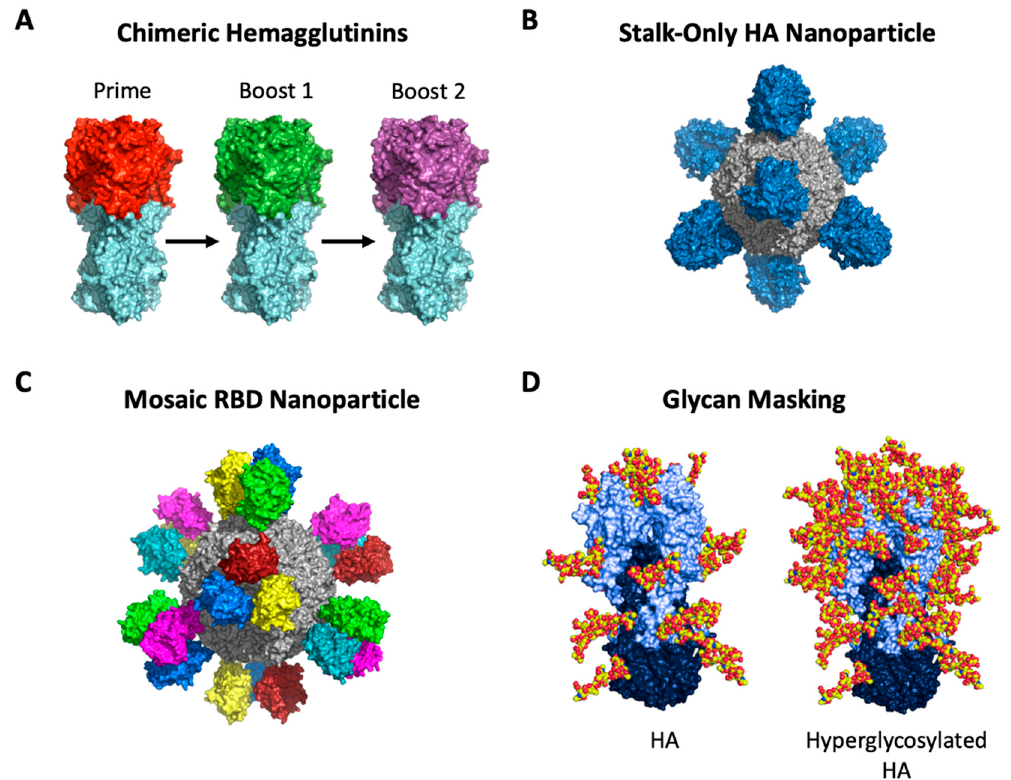
Figure 4. Select immune refocusing strategies to elicit broad cross-reactive HA stalk- and head-targeting antibodies. Strategies include ( A ) sequential immunization with chimeric HA (cHA) immunogens, ( B ) stalk-only HA nanoparticle immunogens, ( C ) mosaic RBD nanoparticles, and ( D ) glycan-masking.